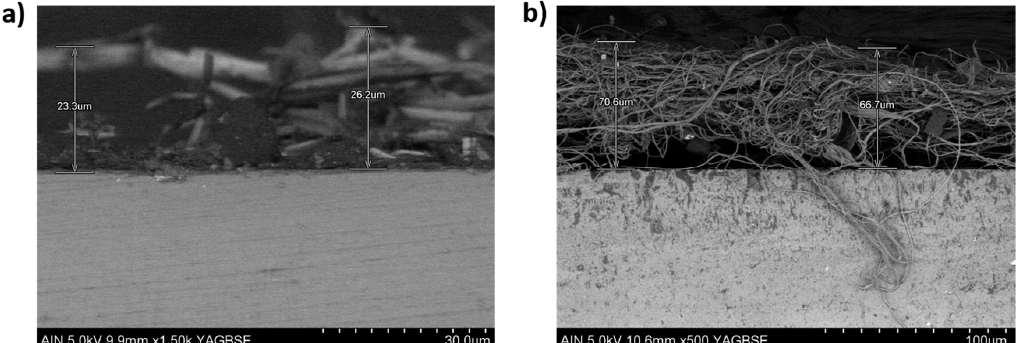
Figure 13. Cross-sectional SEM image of the PS ( a ) and PVC ( b ) electrospun fibre coating with their corresponding thickness. Reprinted with permission of [73].